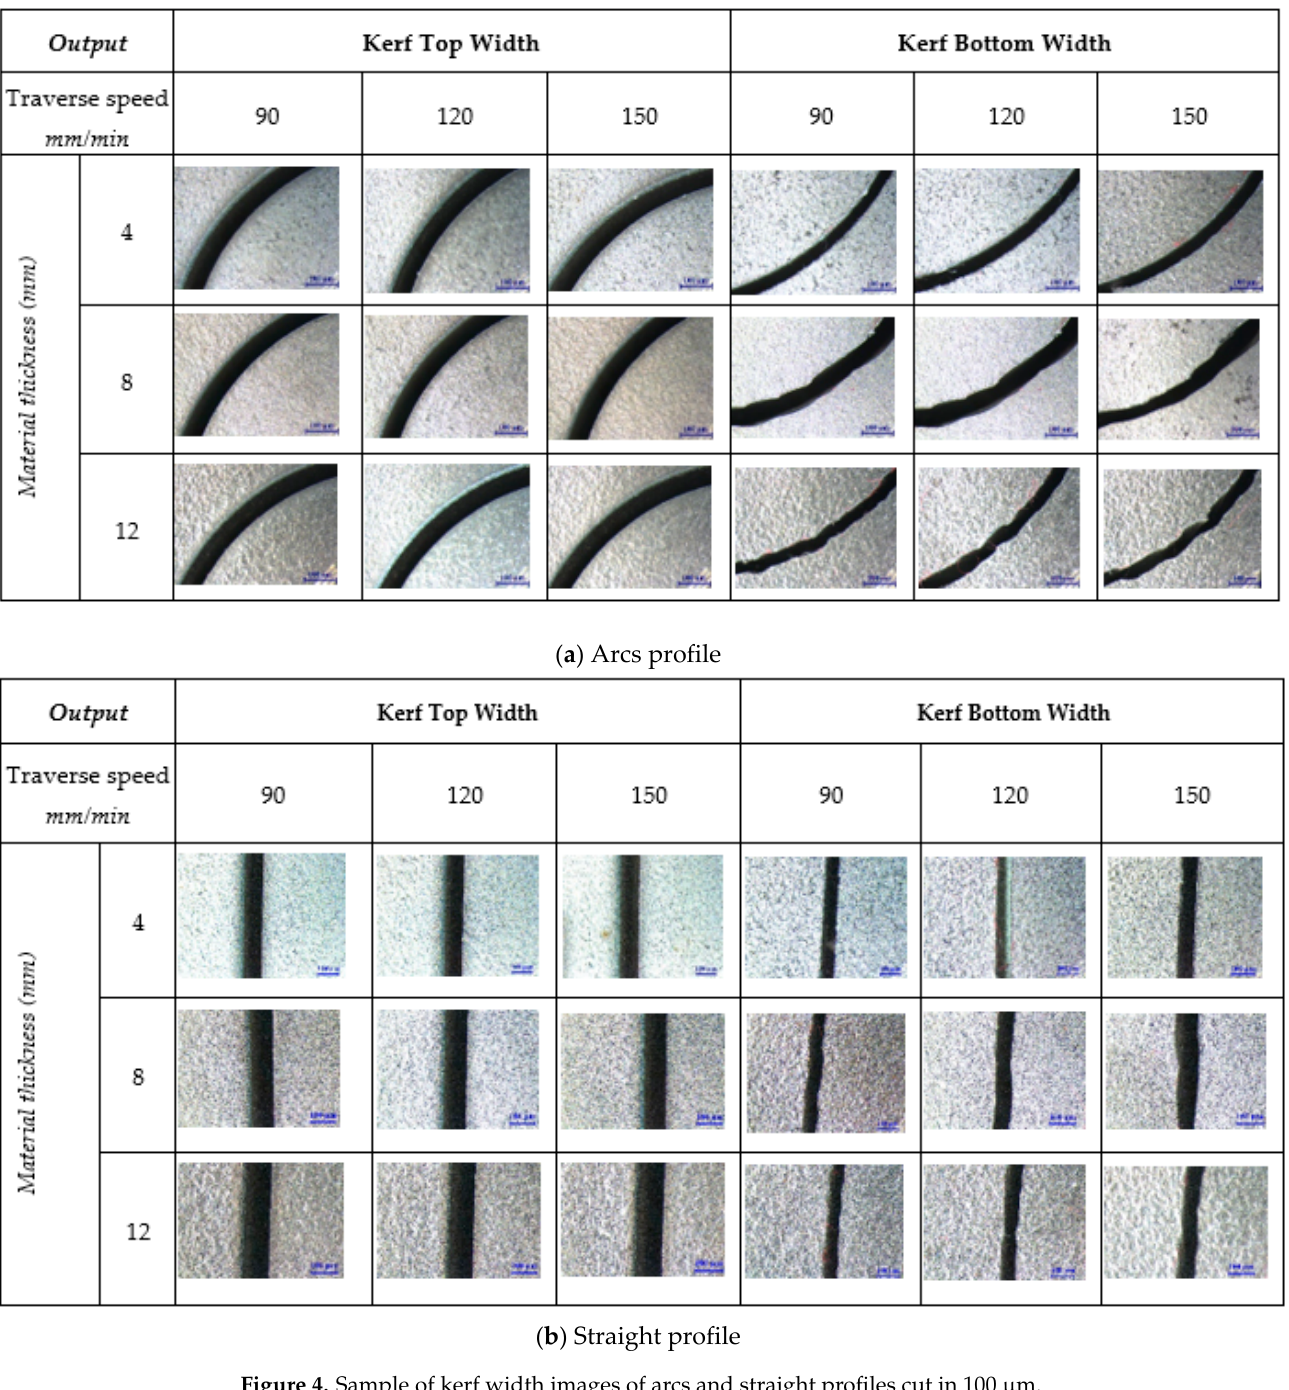
Figure 4. Sample of kerf width images of arcs and straight profiles cut in 100 µm.